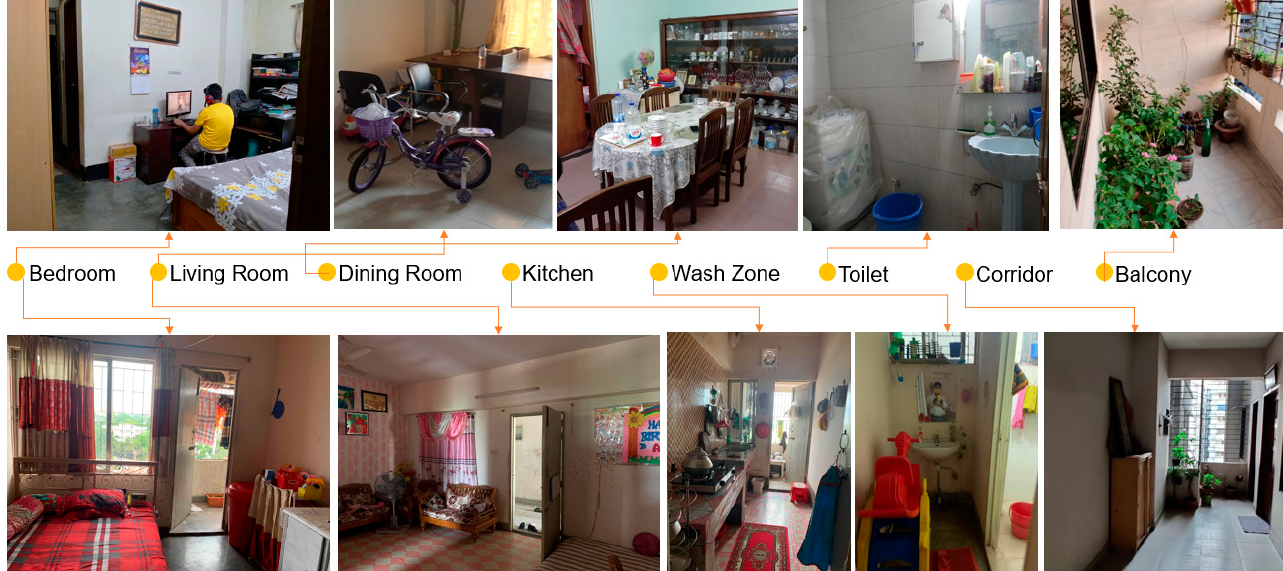
Figure 6. An example of domestic living environments in Dhaka, Bangladesh. Source: (Residents took photos from high-density urban housings, Dhaka, Bangladesh).